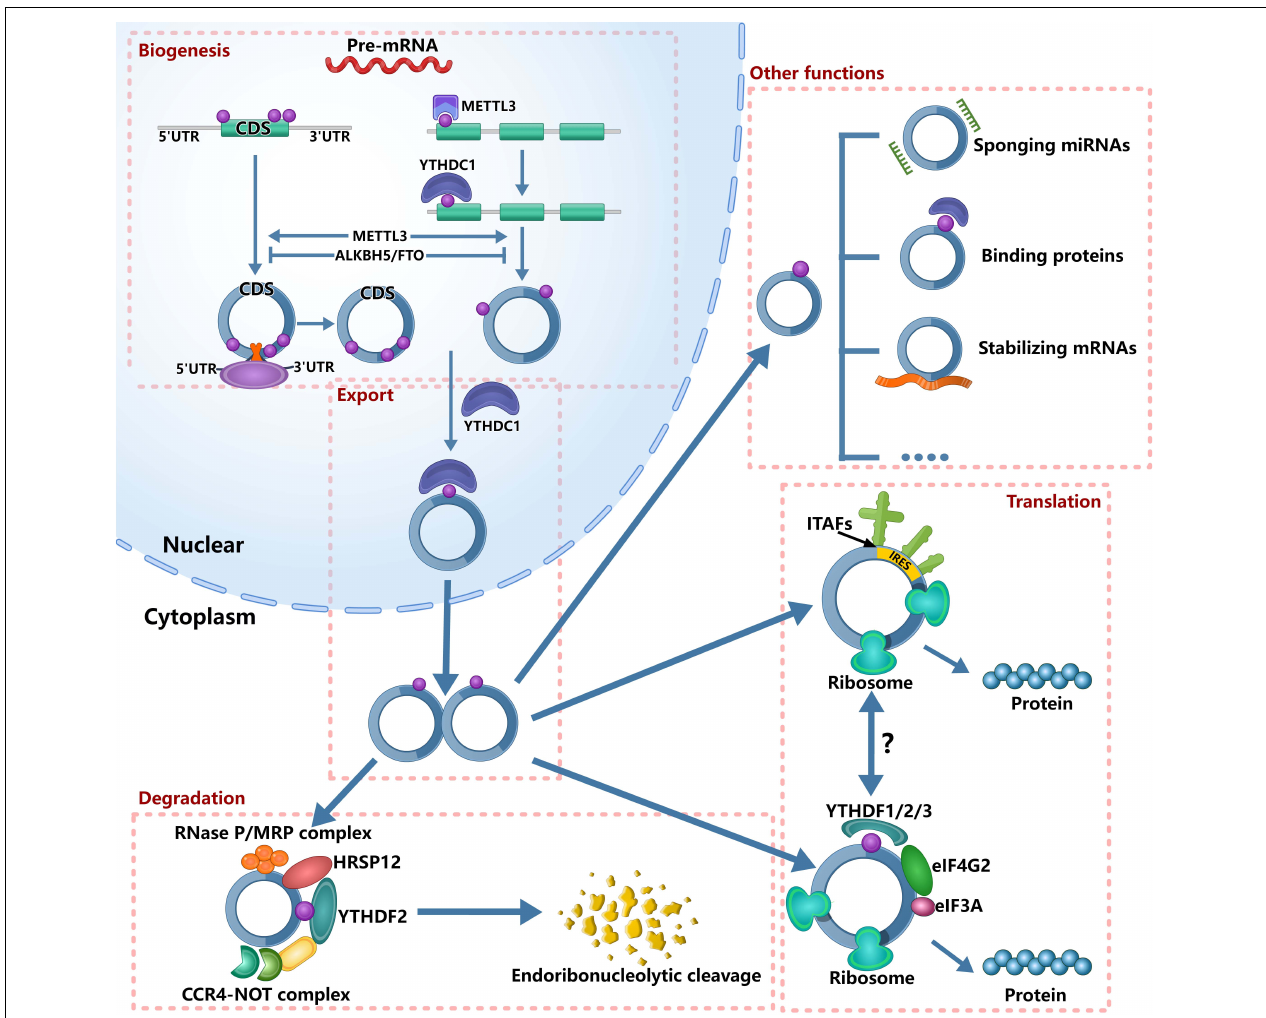
FIGURE 1 | Roles of m6A in circRNA metabolism. It’s has confirmed that m6A can regulate circRNA metabolism, including circRNAs biogenesis, translation, degradation and cellular localization. On the one hand, m6A sites located around the start and stop codons in linear mRNAs can recruit spliceosome, leading to back splicing and circRNA production. On the other hand, m6A deposition and YTHDC1 binding to exons can regulate circularization. In the nucleus, the m6A can bind specific nuclear reader proteins, mainly YTHDC1, which can promote the export of circRNAs. Upon circRNAs export to the cytoplasm, m6A binds to specific reader proteins and other proteins to stabilize some mRNAs. The nuclear export of circRNAs also affects its miRNA sponges. The translation of circRNAs is only in cap-independent translation initiation mechanisms: IRES-dependent initiation of translation and m6A-dependent initiation of translation. m6A-driven translation